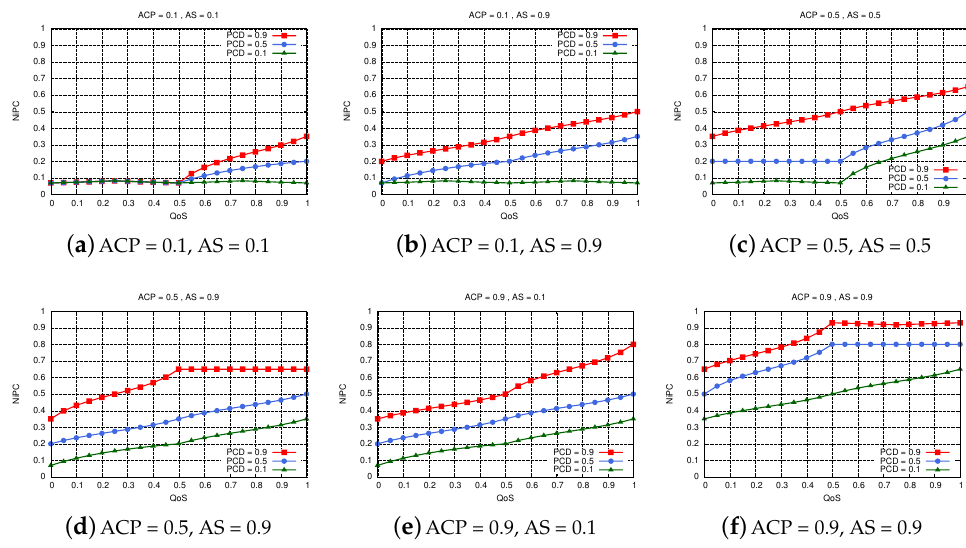
Figure 9. Simulation results for